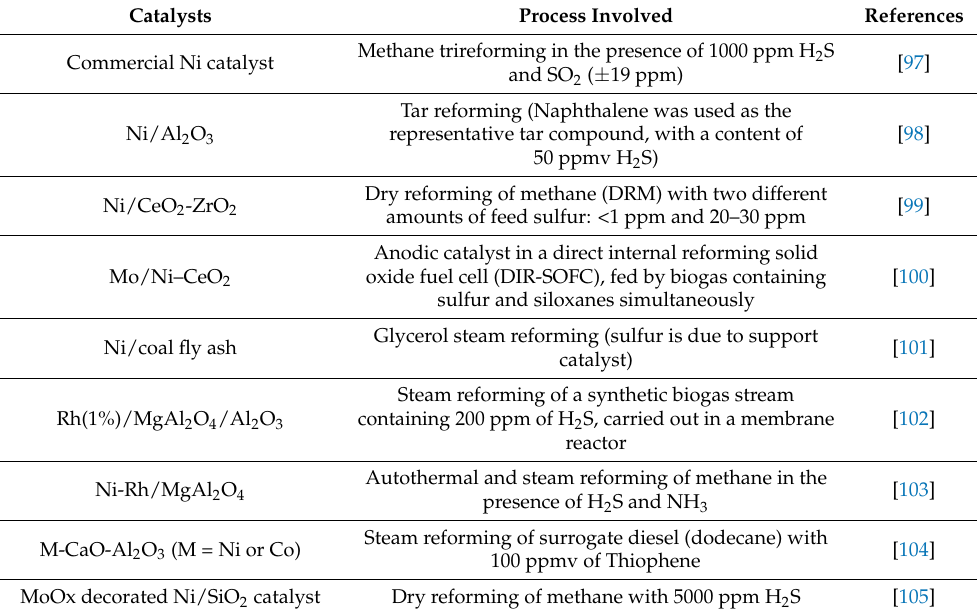
Table 1. Representative recent trends (last two years) on the catalyst interactions of the reforming of biofuels with sulfur